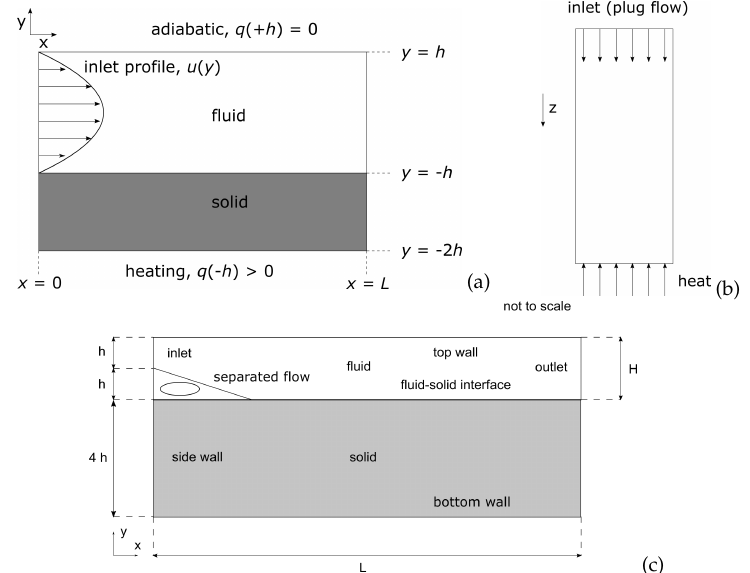
Figure 2. Schematics of problems exhibiting similar physical behaviour as the full problem. (a) fully developed forced convection and conjugate heat transfer in a planar channel. (b) one-dimensional conduction against convection. (c) backward-facing step flow with a heated downstream wall. Note that analytical solutions are derived here for cases (a) and (b).